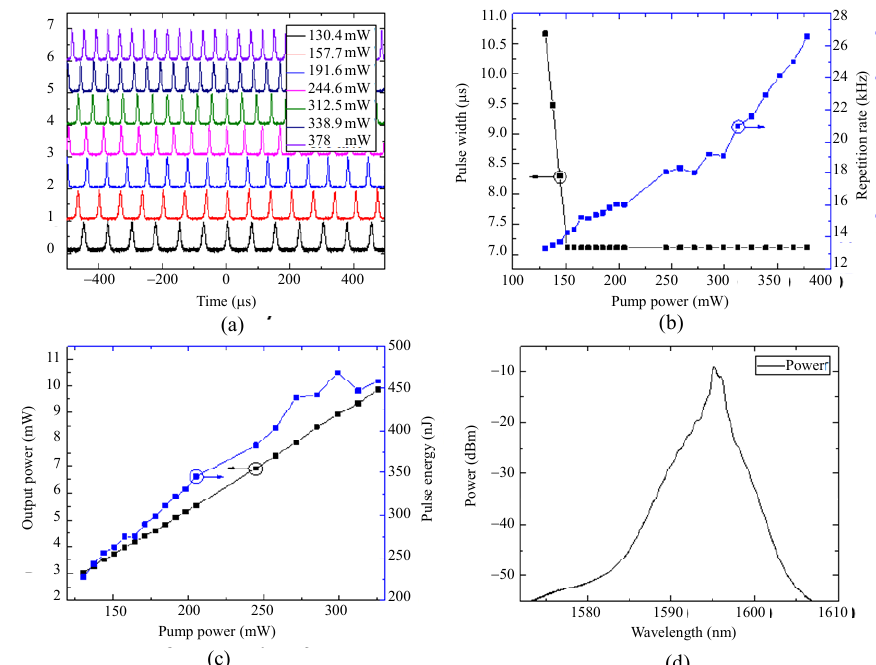
Fig.4 Performance of the developed Q-switched fiber laser: (a) different pulse trains under different pump powers, (b) pulse width and repetition rate versus pump power, (c) output power and pulse energy versus pump power, and (d) optical